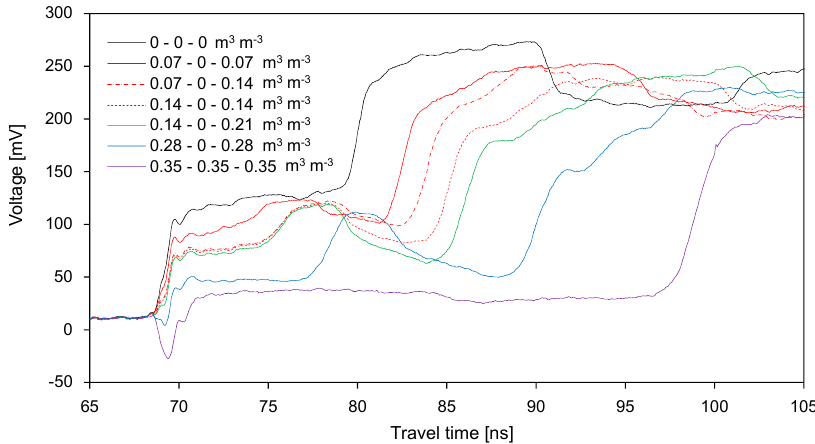
Figure 10. Variance of the signals with the SWC in the wet-dry-wet treatment.